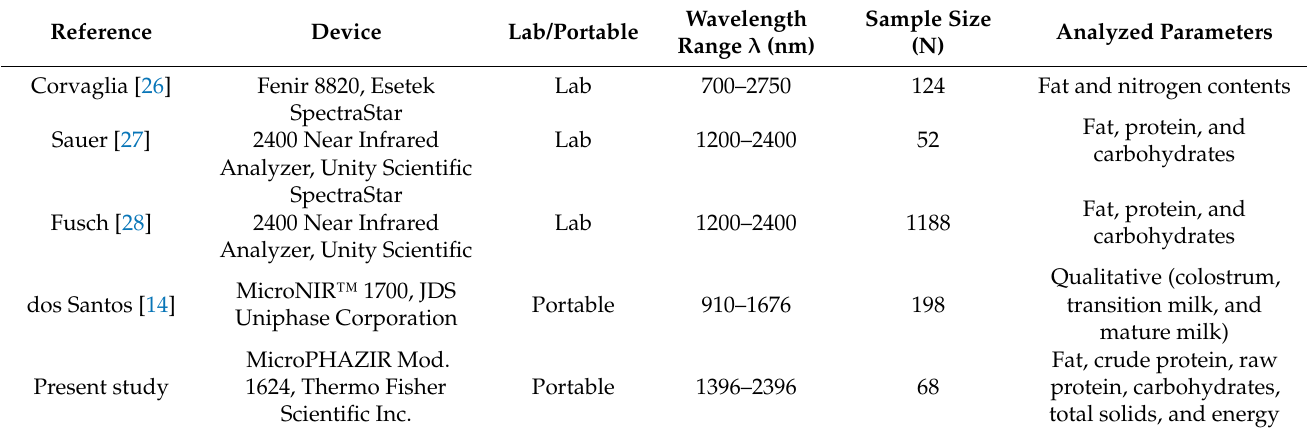
Table 4. An overview on reported NIRS-based methods for breast milk analysis.